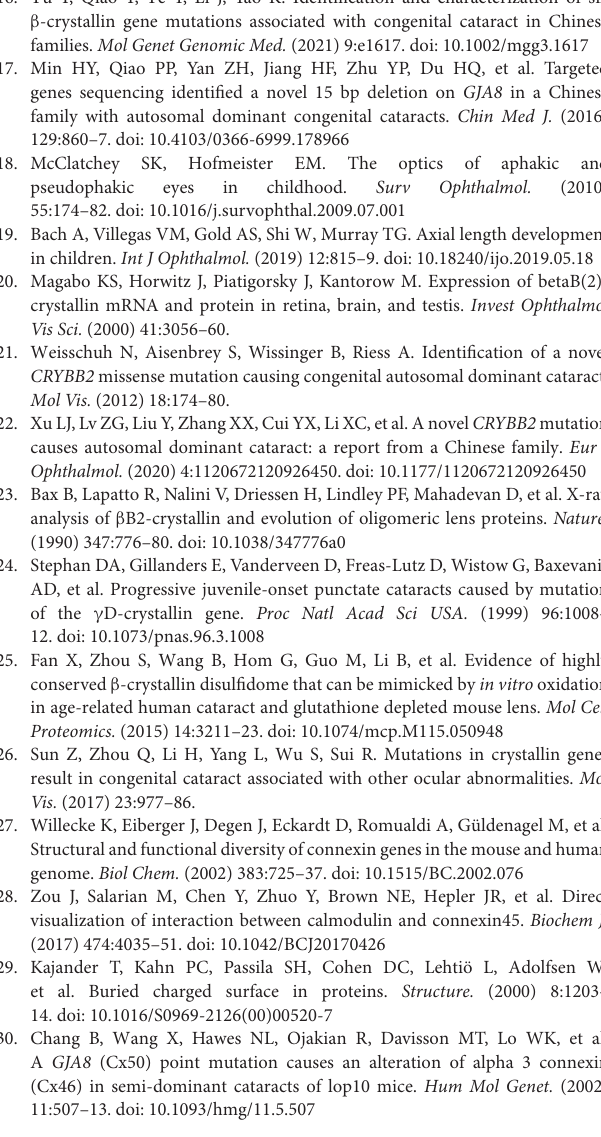
Supplementary Table 1 | Primers that were used in Sanger sequencing. Supplementary Table 2 | Other variants that were detected in the six unrelated congenital cataracts